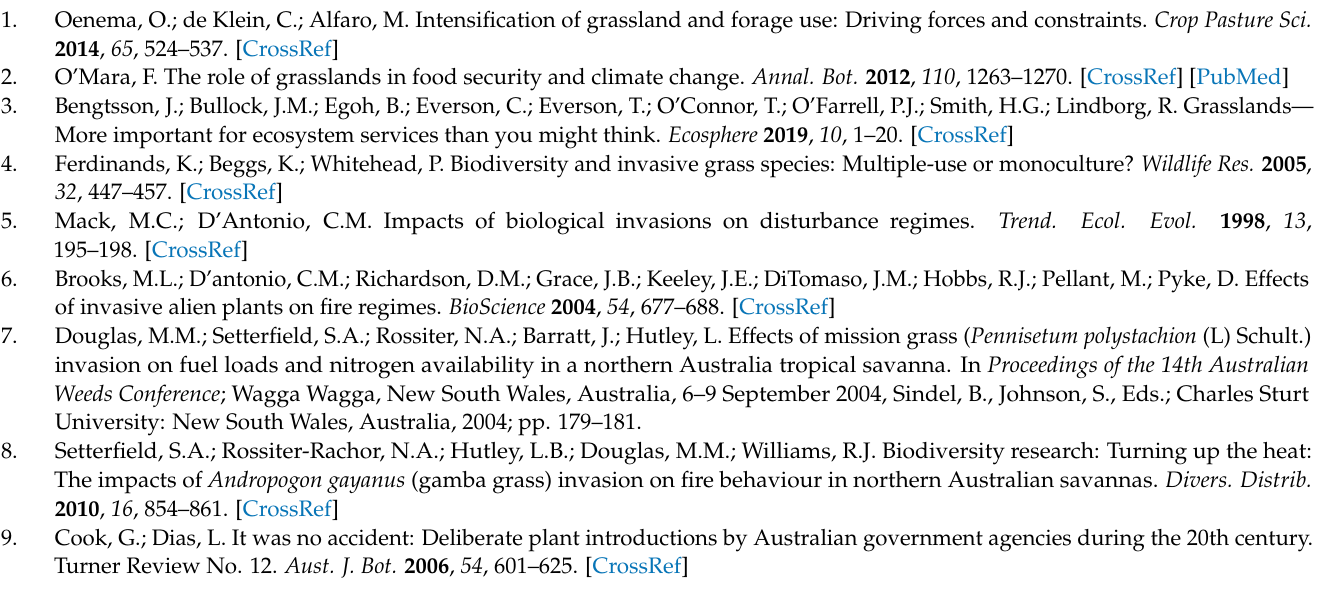
Table S4: Spectral Feature Fitting separability results (VNIR-SWIR). Table S5: Spectral Feature Fitting separability results (350–1000